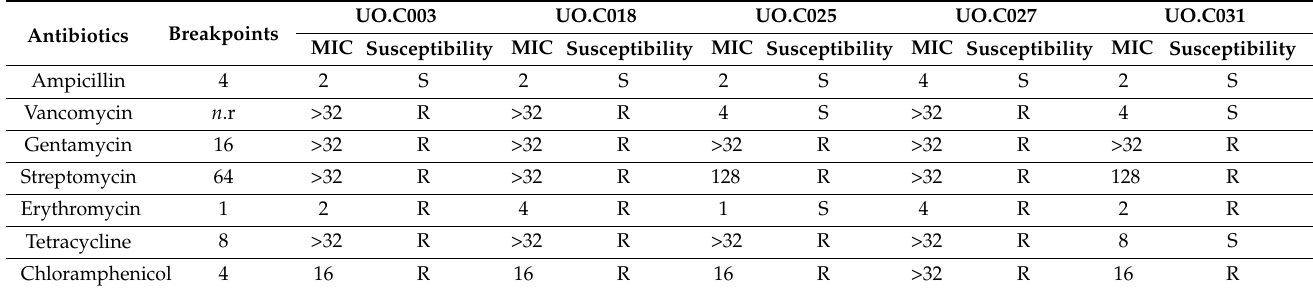
Table 6. Minimum inhibitory concentration (MIC in µ g/mL) and interpretation of selected strains.